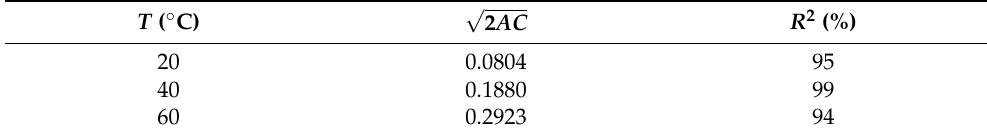
Table 10. Values of